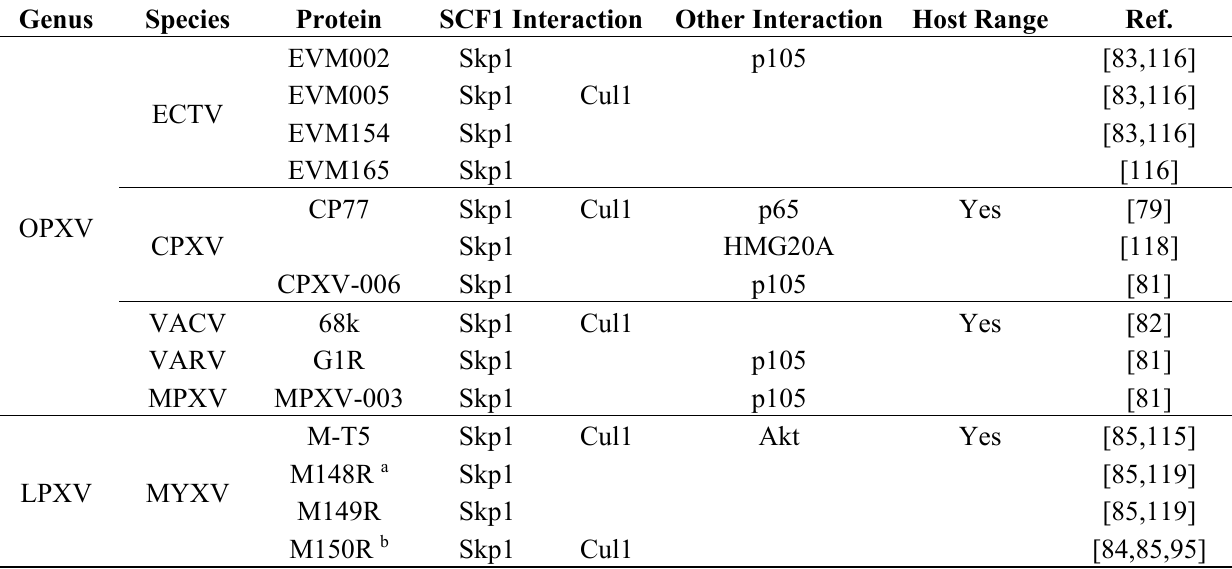
Table 3. Poxviral ANK/F-box proteins and their described interaction partners. Known interacting proteins include key components of the SCF1 ubiquitin ligase complex (Skp1 and Cul1), with other known protein interactions also